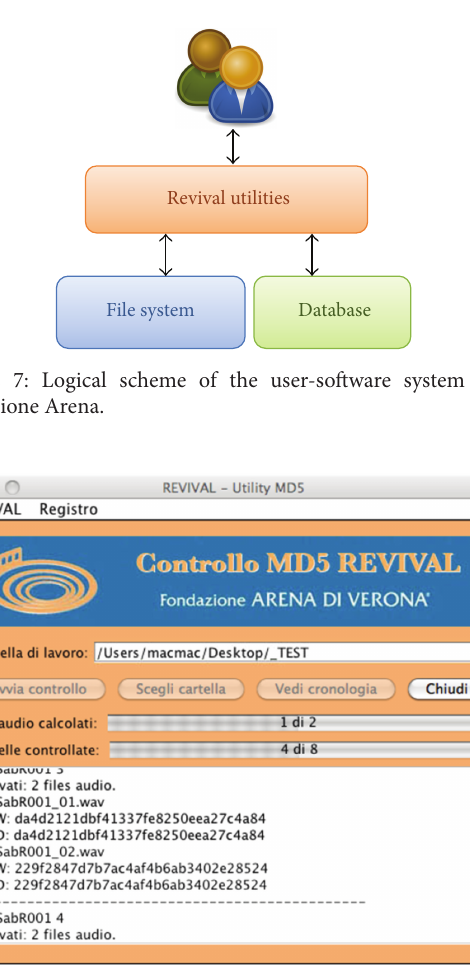
Figure 8: One of the software tools developed for the Fondazione Arena di Verona. This utility performs a consistency control on the checksums of the stored preservation copies and should be run periodically. The utility processes the entire archive of preservation copies and outputs a log in real-time, informing the operator about the remaining time by means of two progress bars (one for the number of preservation copies and one for the single audio files). The output on the screen reports the files that are being processed at the moment: in case of a mismatch between the checksums, an alert message is notified to the